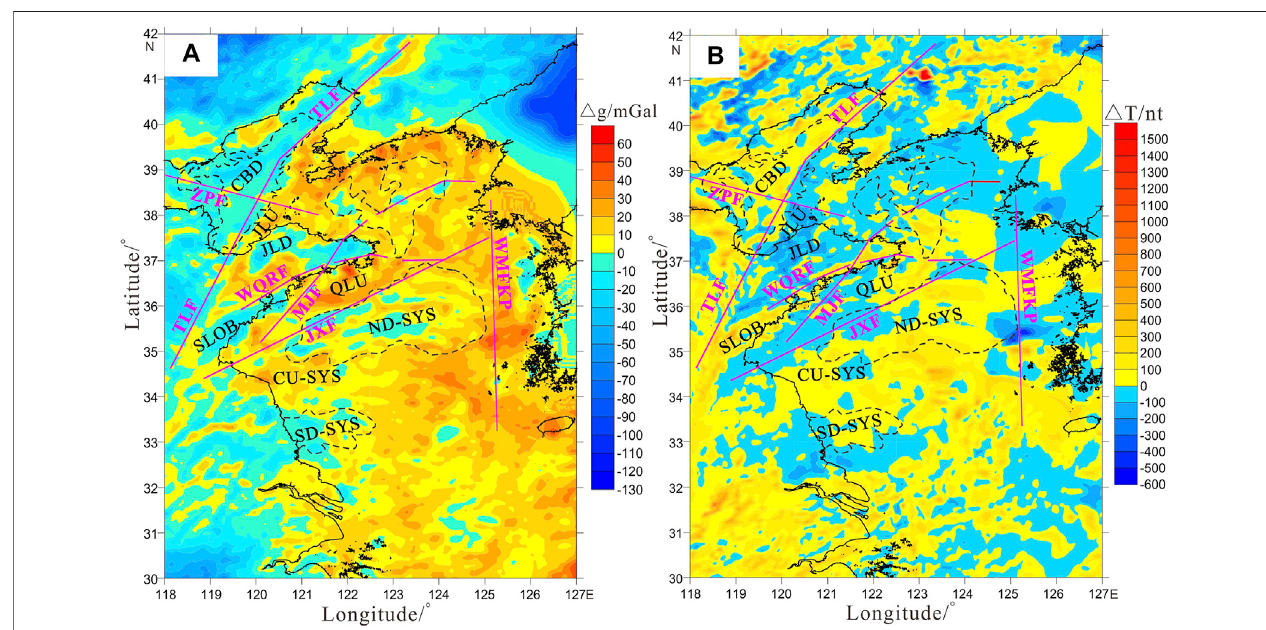
FIGURE 3 | The Bouguer gravity anomaly (A) and the reduction to pole magnetic anomaly (B) of the study area (after Hao et al., 2010). The black dashed boxes indicate the depressions in the sea area. The pink solid lines are the main great faults in the study area, including: ZPF, Zhangjiakou-Penglai Fault; TLF, Tanlu Fault; LYF, Lianyan Fault; WQRF, Wulian-Qingdao-Rongcheng Fault; MJF, Muping-Jimo Fault; JXF, Jianshan-Xiangshui Fault; WMFKP, Western Marginal Fault of Korean Peninsula.Themaintectonicunitsinclude:CBD,CentralBohaiDepression;JLU,JiaoliaoUplift;JLD,JiaolaiDepression;SLOB,SuluOrogenicBelt;QLU,Qianliyan Uplift; ND-SYS, Northern Depression of SYS; CU-SYS, Central Uplift of SYS; SD-SYS, Sourthern Depression of SYS.